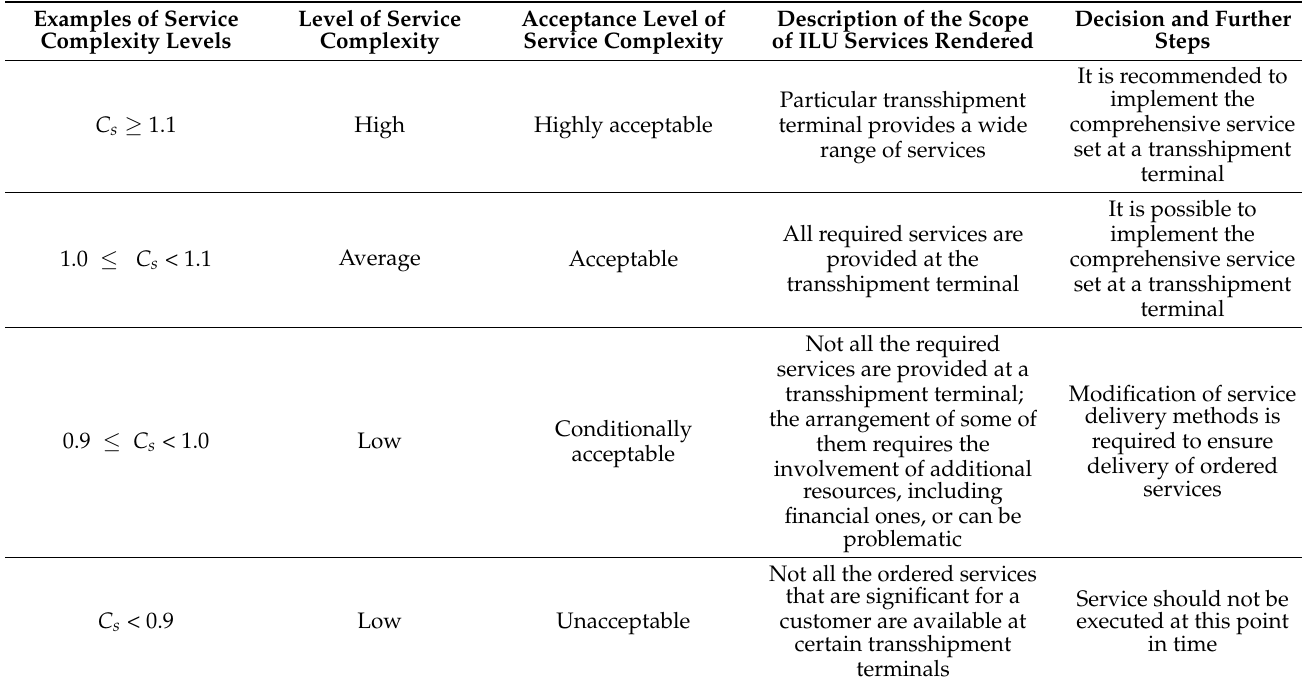
Table 3. Examples of acceptance ranges for the level of ILU service complexity at transshipment